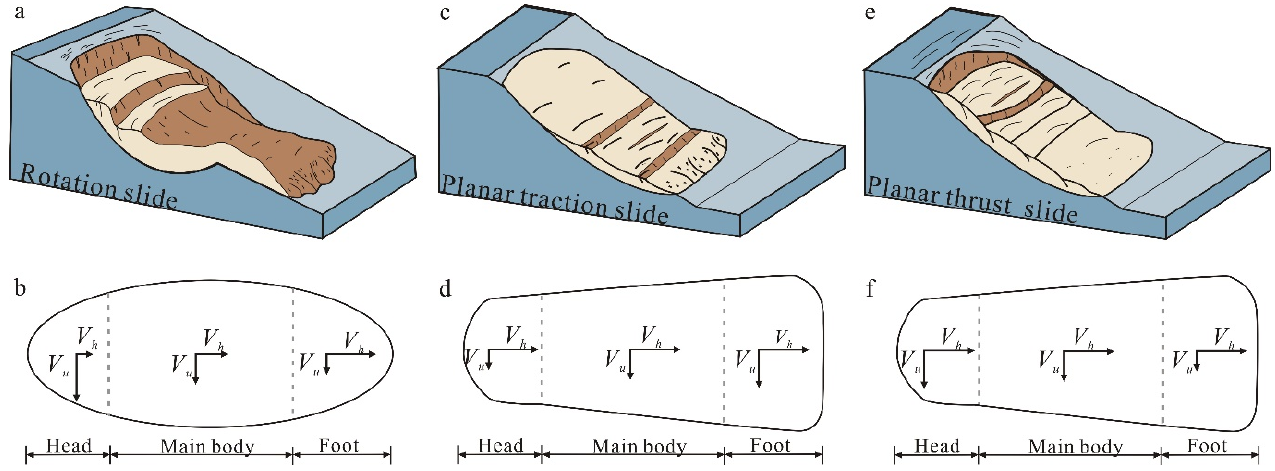
Figure 6. ( a ) Schematic diagram of rotational slide; ( b ) plane velocity distribution of rotational landslide; ( c ) schematic diagram of planar traction slides; ( d ) plane velocity distribution planar traction slide; ( e ) schematic diagram of planar thrust slide; ( f ) plane velocity distribution of pla- nar thrust slide; Vu is vertical displacement velocity, Vh is horizontal (slope-oriented) velocity (modified after